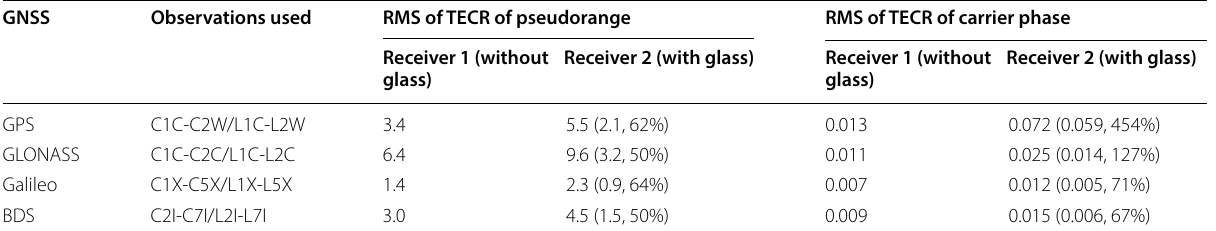
Decimal numbers and percentages in parentheses correspond to increases in TECR RMS of receiver 2 relative to receiver 1 and the percentage of increase, respectively. Unit: TECU/s